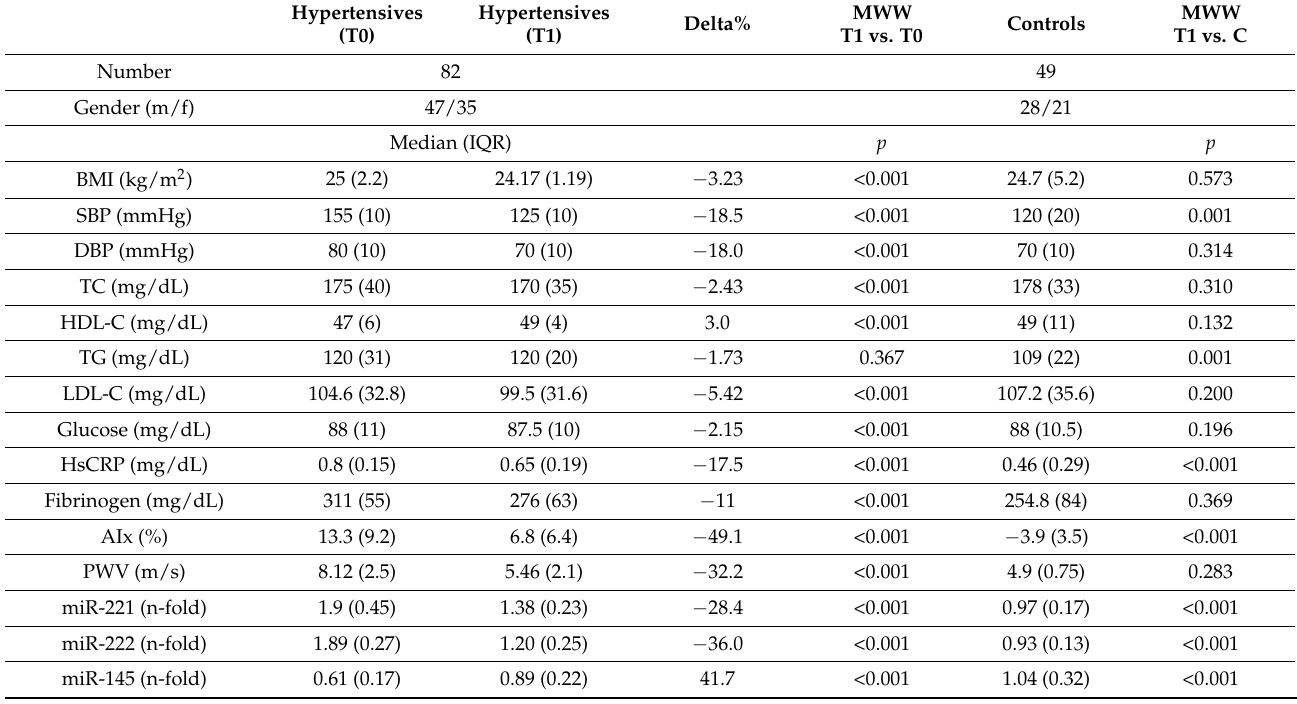
Table 2. Characteristics of hypertensive patients at baseline (T0) and after 6-month antihypertensive therapy